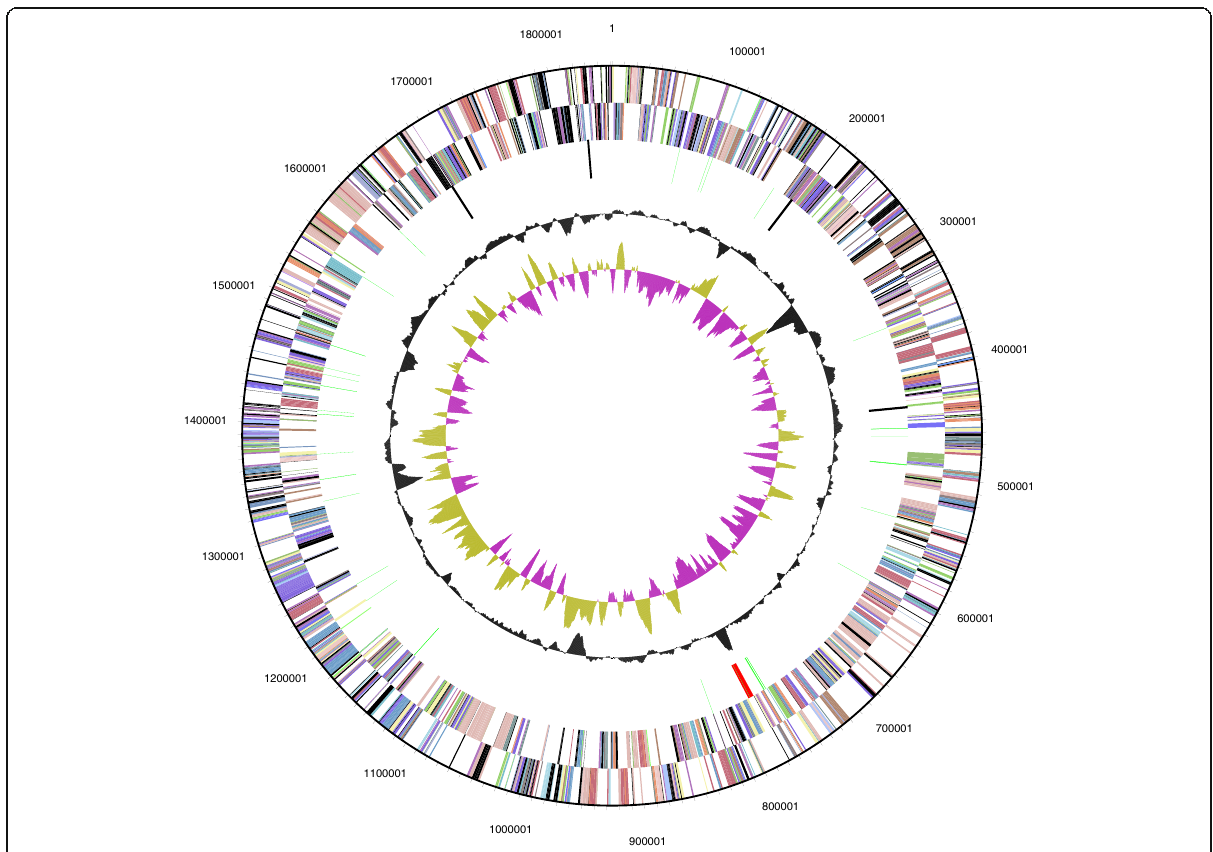
Fig. 3 Chromosomal map of T. sp. strain RQ7. From outside to the center: genes on forward strand (color by COG categories), genes on reverse strand (color by COG categories), RNA genes (tRNAs: green, rRNAs: red, other RNAs: black), GC content (black), GC skew (olive/purple)